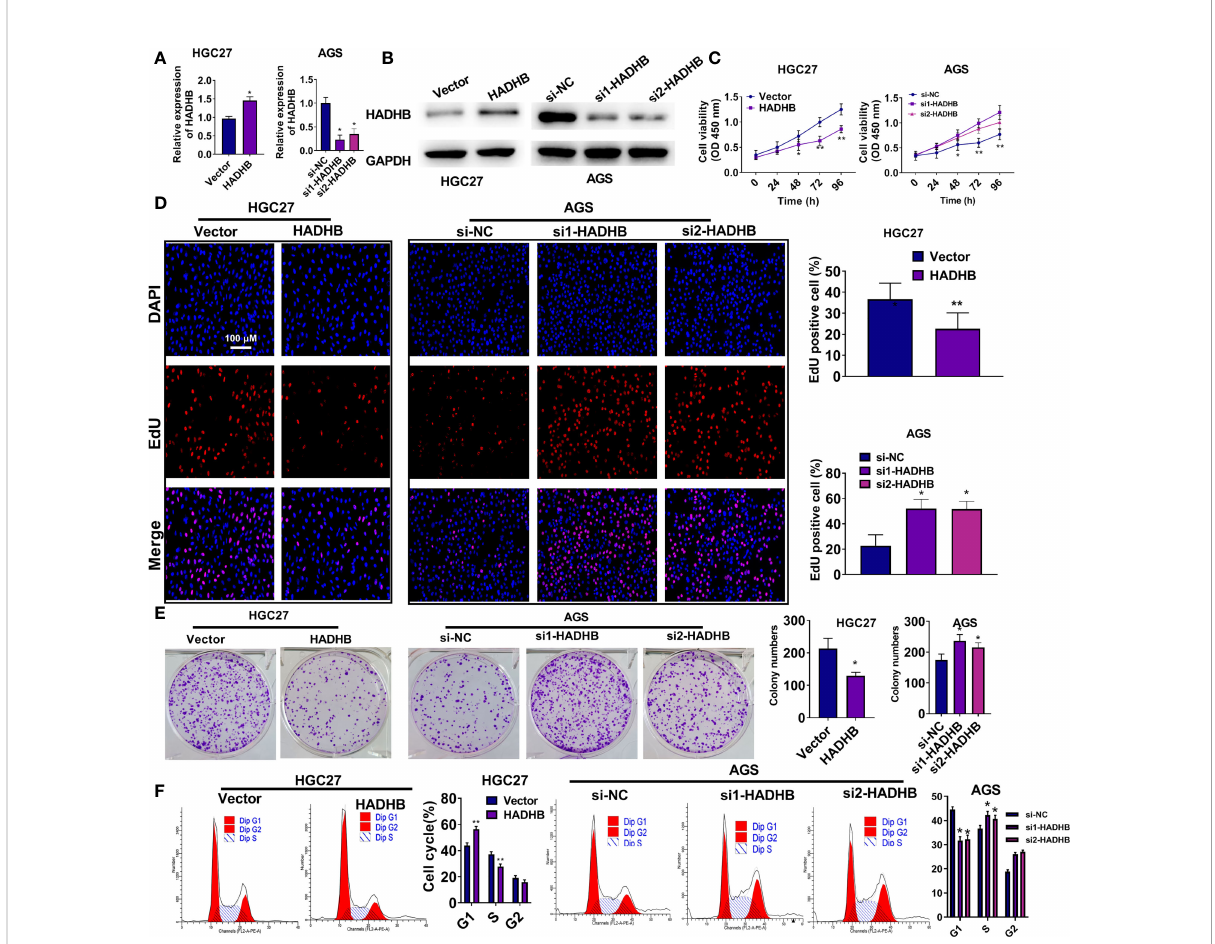
FIGURE 2 HADHB upregulation repressed the proliferation and cell cycle progression of HGC27 and AGS cells (A, B) . HADHB expression in the transfected HGC27 and AGS cells was determined using qRT-PCR and western blot analysis. (C – F) . The viability, proliferation, colony formation, and cell cycle of the transfected AGS and HGC27 cells were determined using the CCK-8 assay, EdU assay, colony formation assay, and fl ow cytometry analysis, respectively. * P < 0.05, ** P <